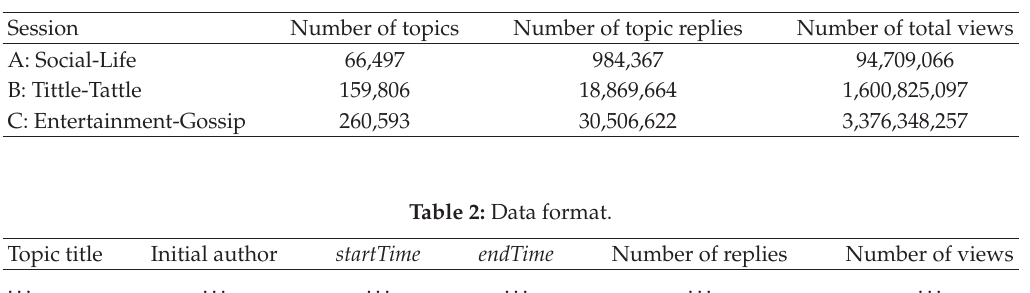
Figure 1 (cid:3) experiments, for example, di ff erent N , varying ordering strategies. Figure 2